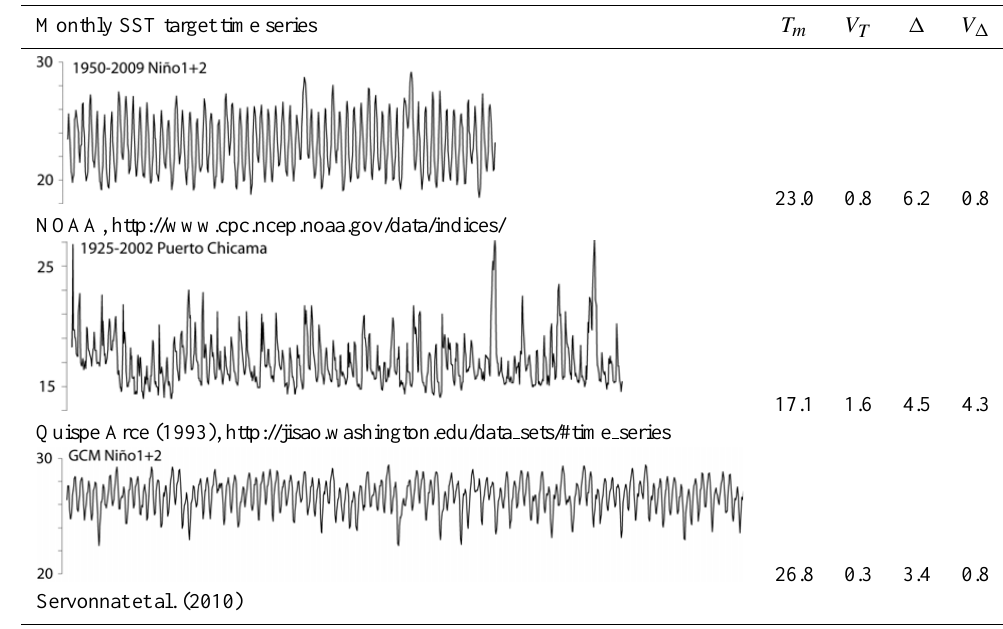
Table 2. Characteristics of monthly SST time series used as target in sensitivity experiments. Only the first 100 years of the GCM Niño1+2 SST time series are shown. The mean and variance of the annual SST ( T m and V T ), and the mean and variance of the seasonal amplitude of SST ( Δ and V ) were calculated for the complete series as described in section 2. Δ